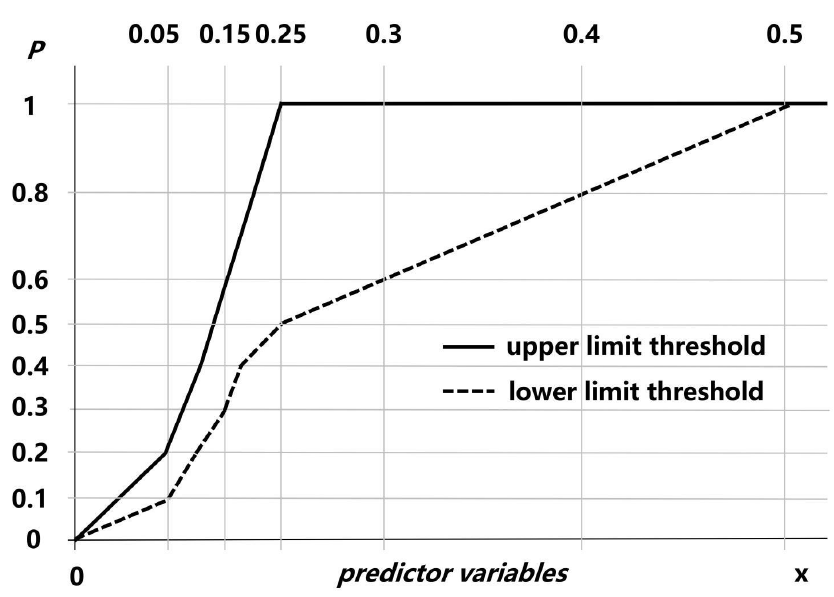
Figure 1. Upper and lower threshold envelopes predicting the probability of each predictor variable on each river function indicator.